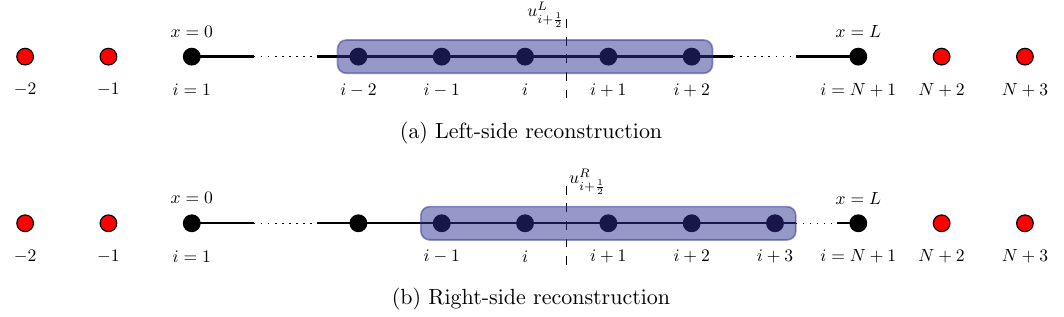
Figure 7. Finite difference grid for one-dimensional problems where the the solution is stored at the interface of the cells. The first and last points lie on the left and right boundary of the domain. The stencil required for reconstruction of left and right side state is highlighted with blue rectangle. Ghost points are shown by red